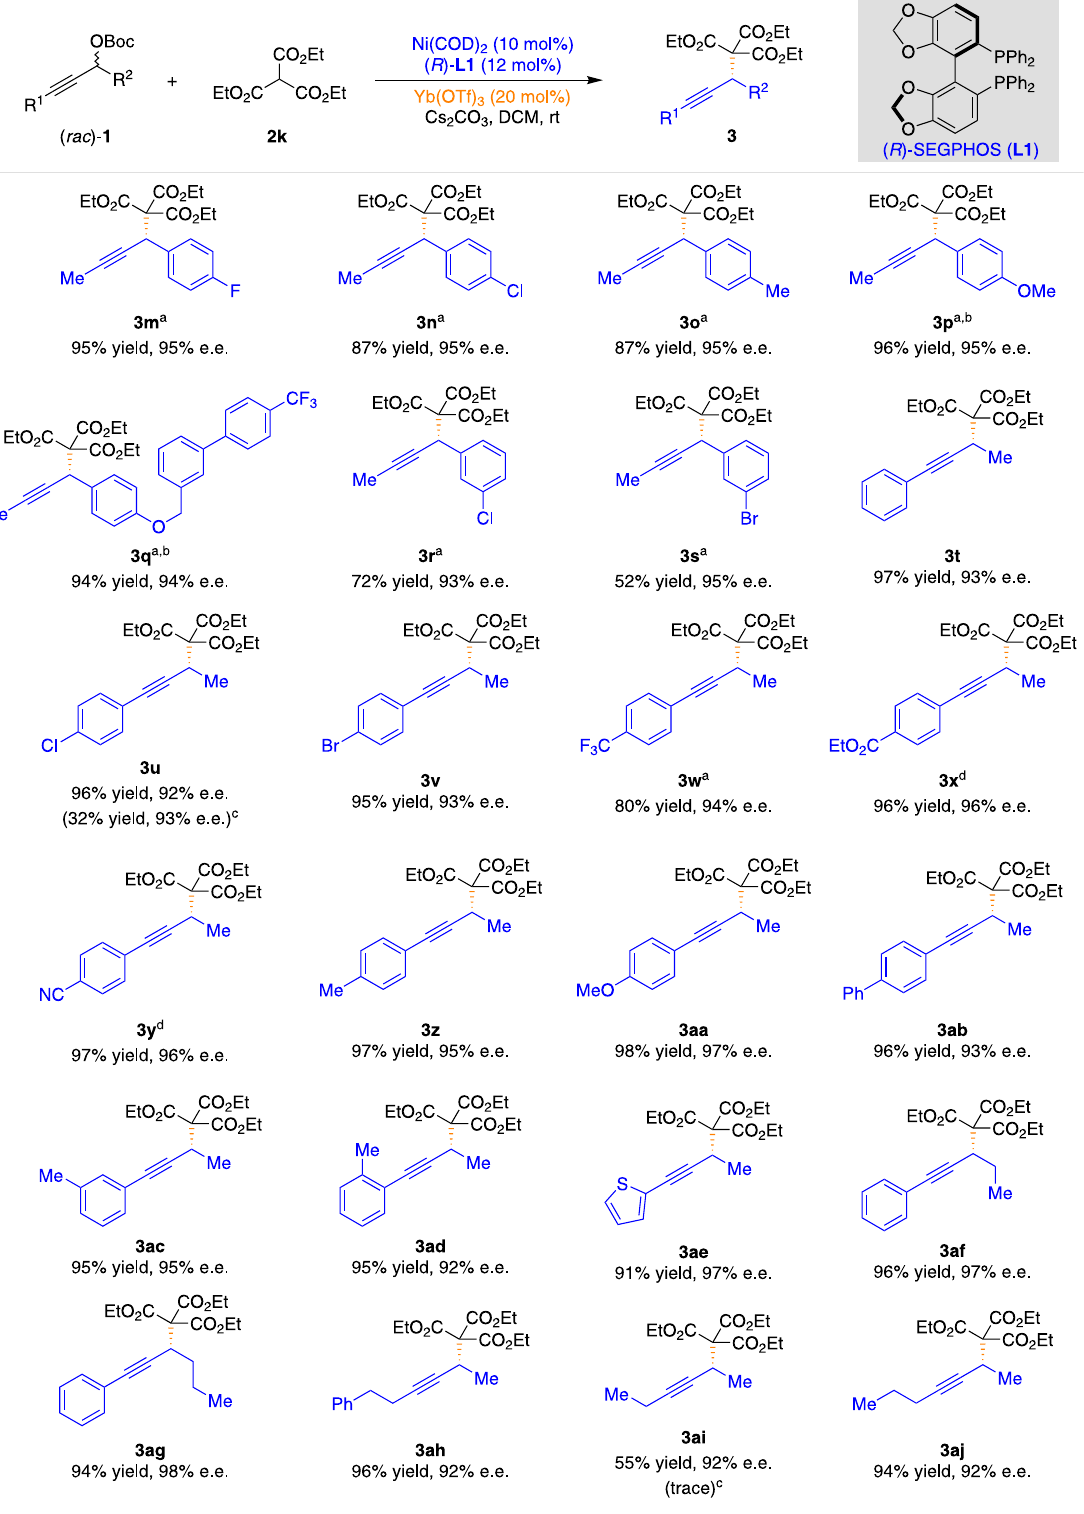
Fig. 3 Substrate scope of various racemic propargylic carbonates. a In toluene (2.0 mL). b In the absence of Lewis acid. c The result for the reaction in the presence of Cu(OTf) 2 (20 mol%) as the Lewis acid under otherwise identical conditions is given in parentheses. d In MeCN (2.0 mL). ( fl uoro, chloro, bromo, methyl, and methoxy) on the benzene ring at the propargylic carbon performed well in the APS reaction, and the corresponding products were isolated in high arenes were well-tolerated and resulted in excellent levels of yields and high enantioselectivities ( 3m – 3s ). Propargylic NATURE COMMUNICATIONS| (2021) 12:299